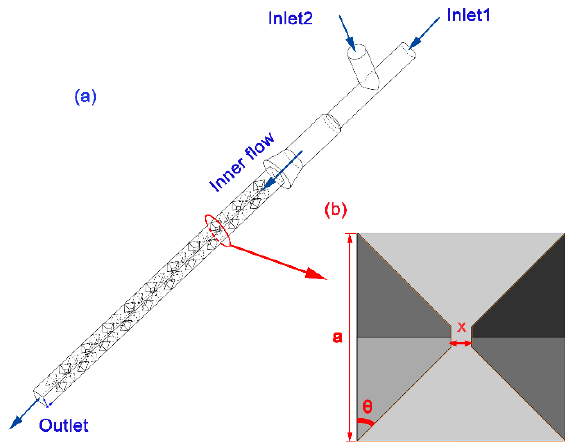
Figure 4. Flow field model in simulation: ( a ) whole reacting pipe model; ( b ) shape of the cross-section.